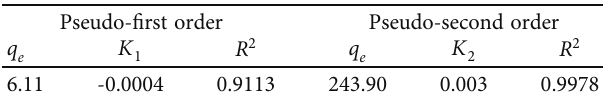
Figure 6: Adsorption kinetic model of MB by ZLCH-b. (a) Pseudo- fi rst order. (b) Pseudo-second order. Table 3: Pseudo- fi rst- and pseudo-second-order kinetic model of MB adsorption onto ZLCH-b adsorbent. Pseudo- fi rst